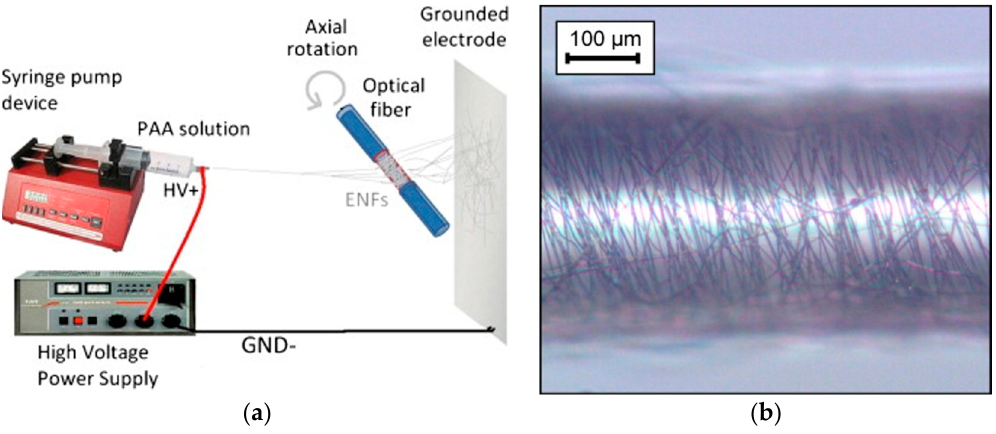
Figure 4. ( a ) Schematic representation of the electrospinning fabrication process where the fiber fragment is placed perpendicularly to the syringe direction in order to collect the ENFs. ( b ) Optical fiber core coated with the ENFs after the fabrication process. Reproduced from [36] with permission; Copyright Elsevier 2013.